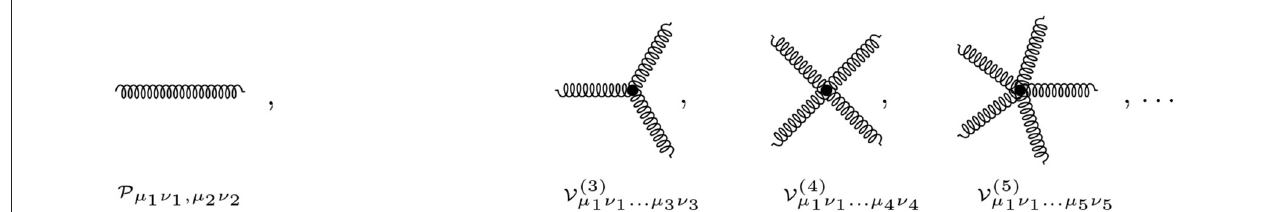
FIGURE 2 | Diagrammatic representation of the propagator and the interaction vertices in